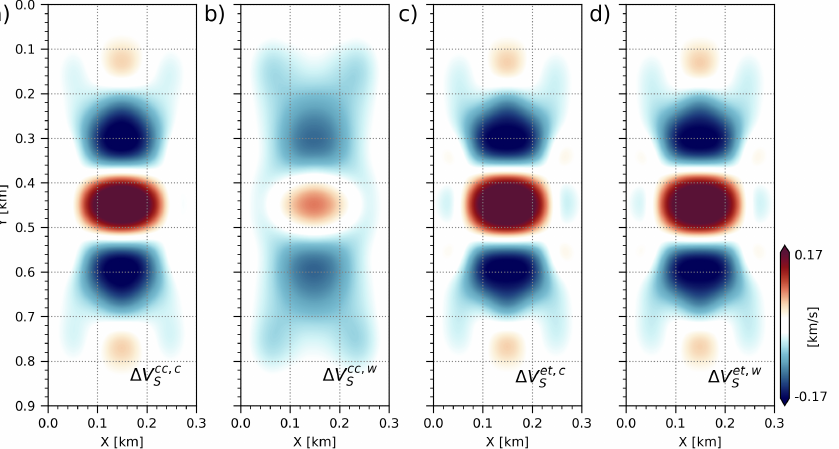
Figure 7. ( a , b ) are the inverted S-wave velocity model perturbations ∆ V cc , c traditional CC objective function with correct and wrong source wavelets; ( c , d ) are the inverted model perturbations ∆ V et , c and ∆ V et , w by ET objective function with correct and wrong source S S